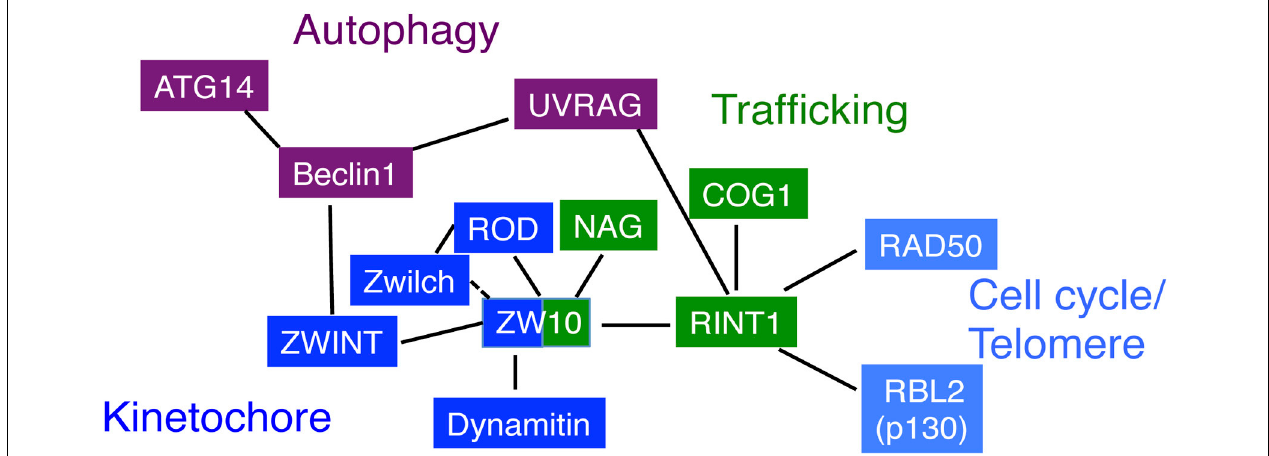
FIGURE 3 | Correlation diagram of NRZ complex subunits. ZW10 is the center for the interactions. Through its N-terminal, putative coiled-coil region, it interacts with RINT1 for membrane trafficking (Hirose et al., 2004; Inoue et al., 2008), dynamitin for recruiting the dynein-dynactin complex (Starr et al., 1998; Inoue et al., 2008), ZWINT for the association with kinetochores (Wang et al., 2004; Kops et al., 2005). The C-terminal region of ZW10 likely interacts with NAG and ROD (Kraynack et al., 2005; Aoki et al., 2009; Civril et al., 2010). The interaction of Zwilch with ZW10 is not tight in the absence of ROD (Civril et al.,